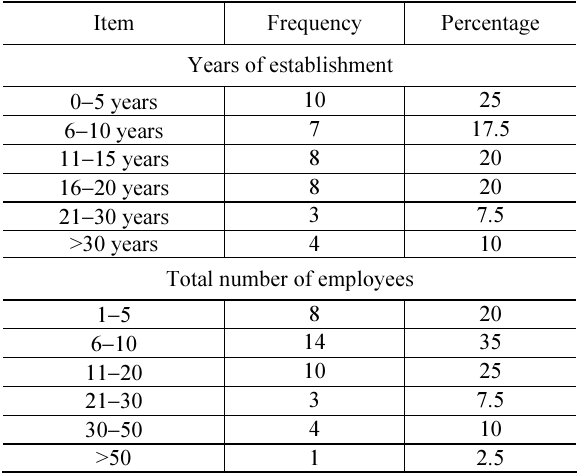
Table 1. Respondent’s company profile